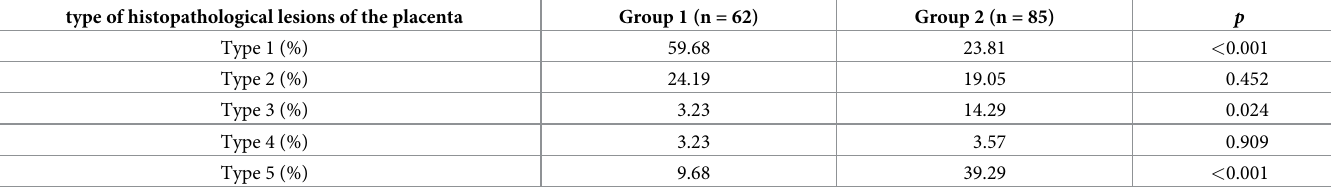
Table 3. Frequencies of placental lesions. type of histopathological lesions of the